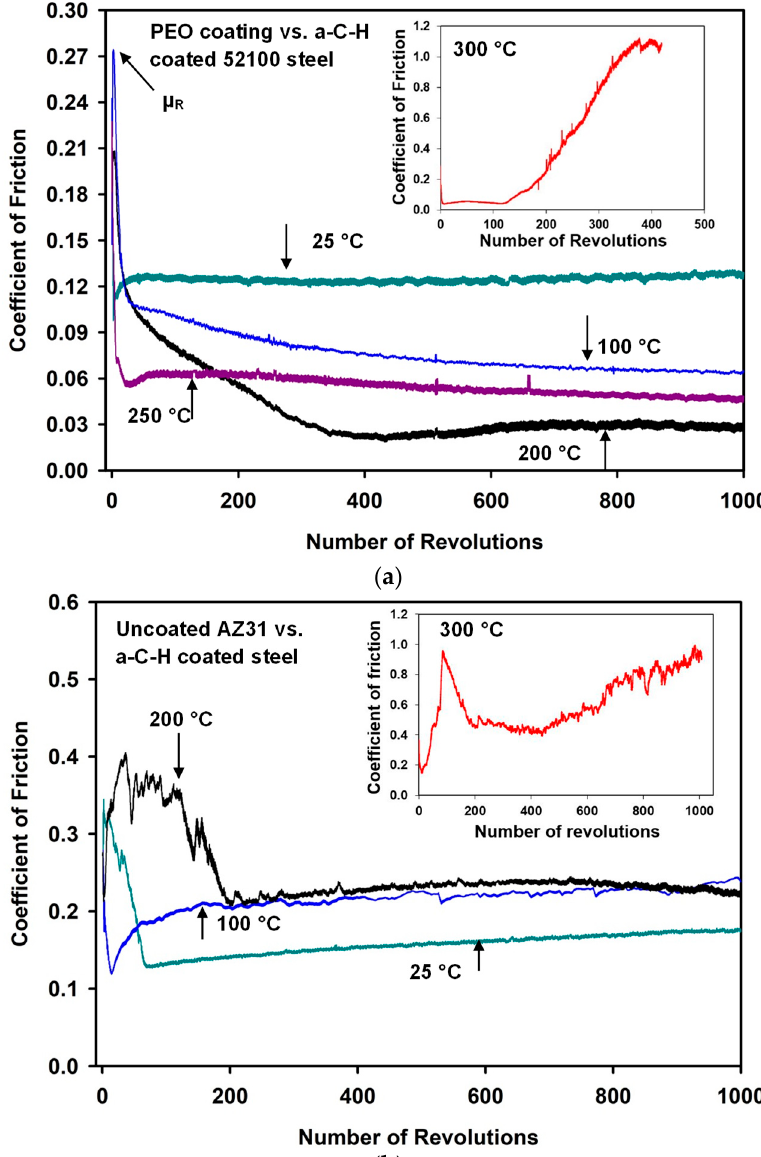
Figure 1. ( a ) The changes in coefficient of friction (COF) values with the number of revolutions when PEO-coated AZ31 tested against a-C-H at 25, 100, 200, 250 and 300 °C; ( b ) The changes in coefficient of friction values with the number of revolutions when uncoated AZ31 was tested against a-C-H at 25, 100, 200 and 300 °C.